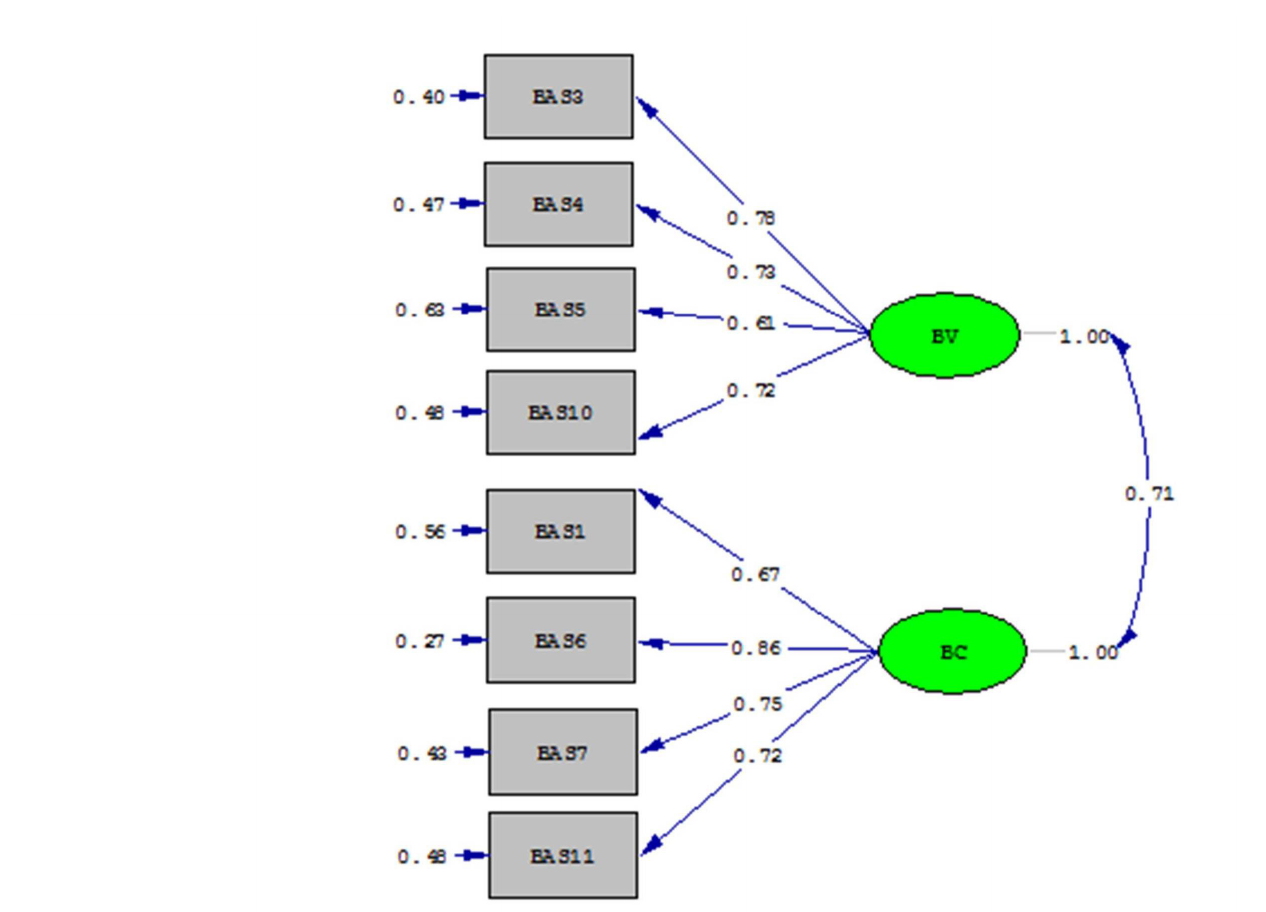
Figure 2. A graphic model of the biidimensional model of the Brazilian version of the BAS for older